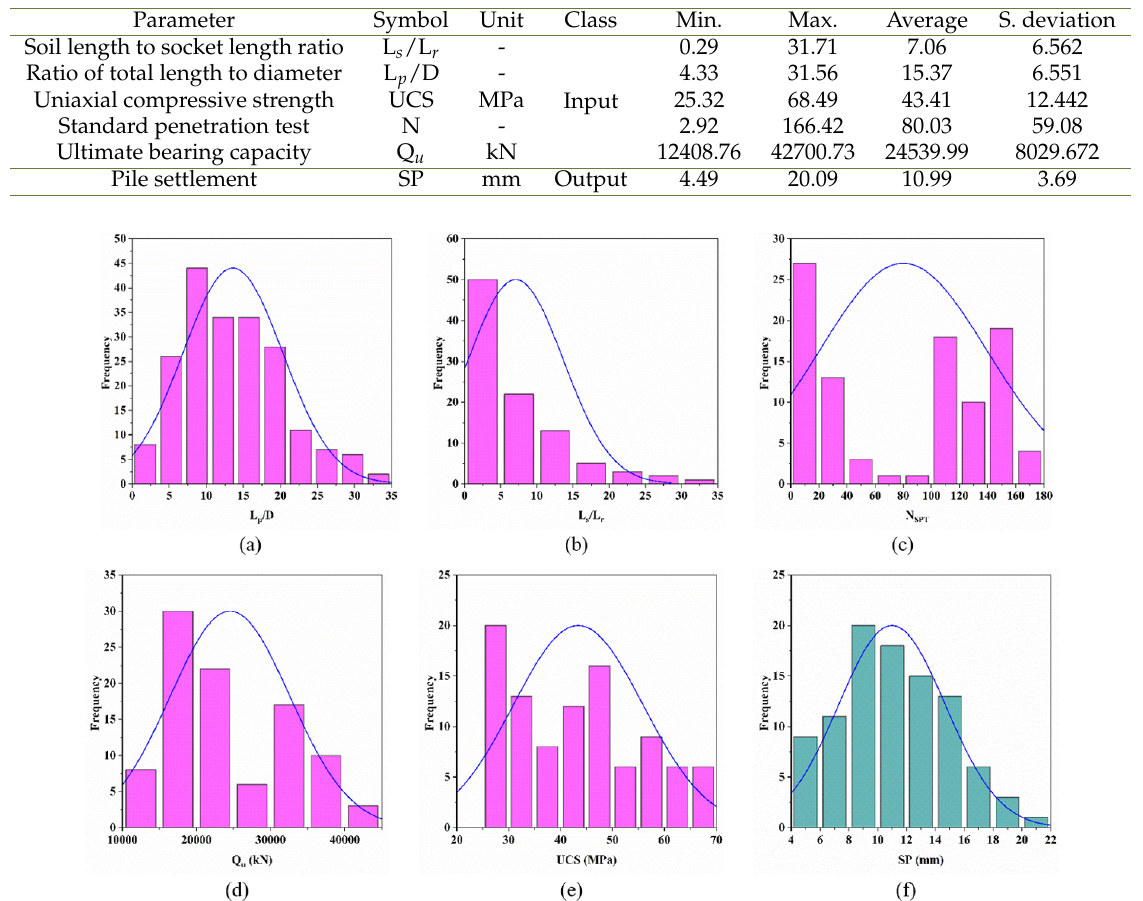
Table 1. The statistical values of the input and output variables